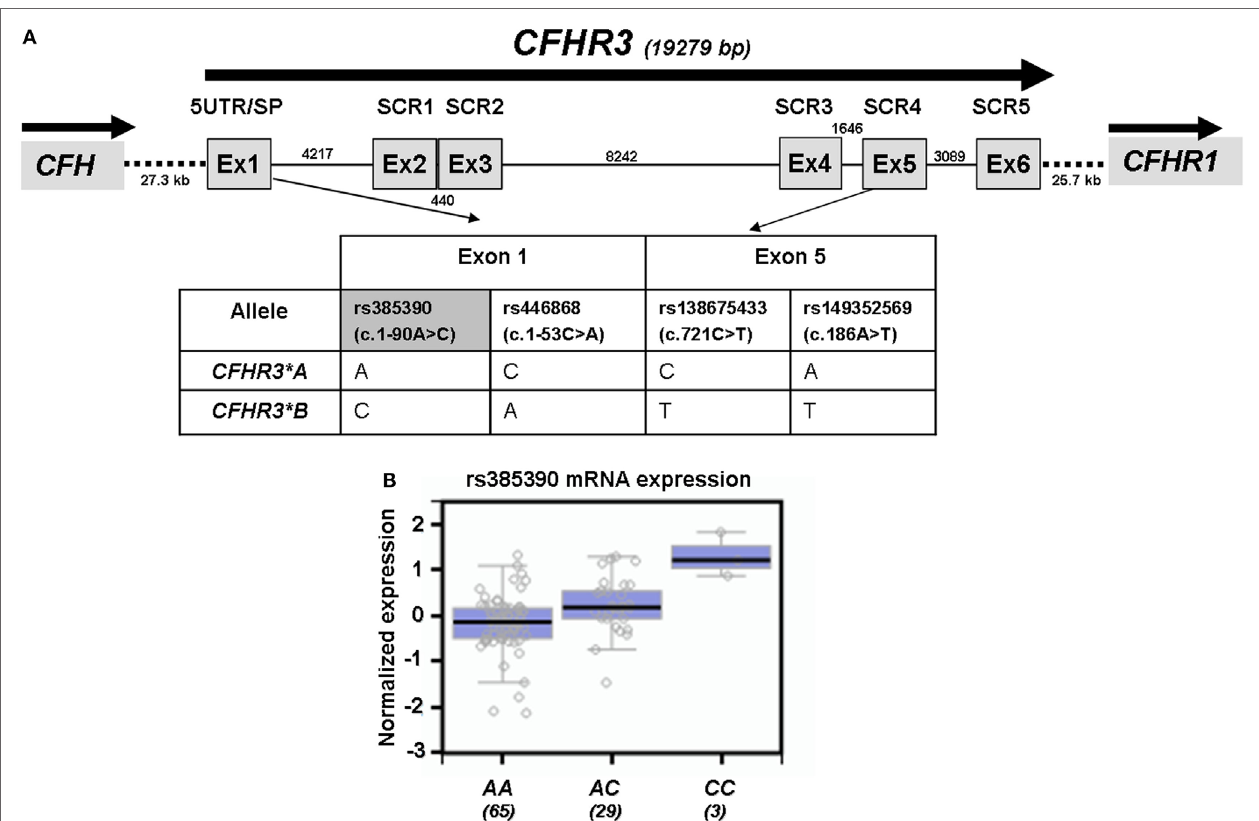
FigUre 1 | Genetic variants associated with the CFHR3*A and CFHR3*B alleles. (a) Exon–intron structure of the CFHR3 gene showing the location of the genetic variants within exon 1 (rs385390; rs446868) and exon 5 (rs138675433; rs149352569) that tag the CFHR3*A and CFHR3*B alleles. (b) In silico data of gene expression correlations from the GTExPortal show that individuals who are homozygous for the rs385390 A variant present lower mRNA expression in liver tissue than individuals homozygous for the rs385390 C variant, or than heterozygous individuals. Number of individuals with each genotype is shown between brackets. GTExPortal: Portal for the Genotype-Tissue Expression project (https://www.gtexportal.org). GTExPortal is supported by the Common Fund of the National Institutes of Health. The data in panel (b) were obtained on October